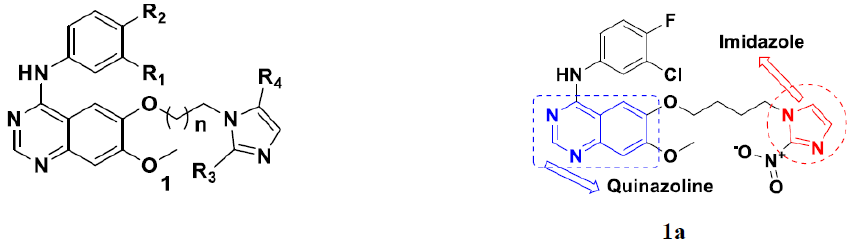
Figure 3. Structure of quinazoline-based deoxynojirimycin hybrids and the most promising com- pound 2a . Table 2. In vitro cytotoxic activities of hybrid compounds 2 ( b – e ).